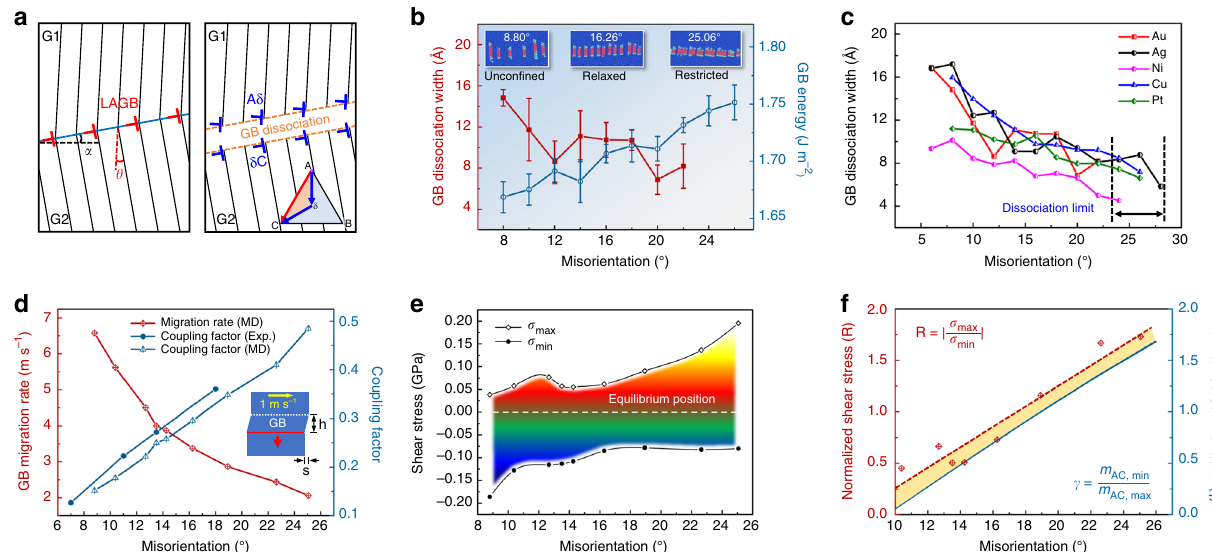
Fig. 3 Generality of the reversible deformation in a variety of metals with different dislocation-type GBs. a Geometrical model of the LAGB con fi guration before (left) and after (right) dissociation. The GB misorientation and inclination are indicated by θ and α in the schematic model, respectively. The inset illustrates the GB dissociation into two Shockley partials on the (111) slip plane. b GB dissociation width and corresponding GB energy for different misorientations. Error bars represent the standard deviations from statistical analyses, where n ranges from 6 to 13 for GB dissociation width (depending on the GB misorientation) and n = 3 for GB energy. c Variations in the GB dissociation width with increasing GB misorientation in different face-centred cubic (FCC) metallic bicrystals. The dashed lines mark the upper limits of the misorientation range for stable GB dissociation in different FCC nanocrystals. d Statistics of migration rates and shear coupling factors ( β = s / h , illustrated by the inset schematic) of LAGBs with different misorientations. e Ranges of applied shear stresses with respect to the GB misorientation. σ max and σ min denote the shear stresses that induced GB migration towards the bottom and top positions in each cycle, and the interval stress states are differentiated by the gradient colours. f Normalized applied shear stresses (R = | σ max / σ min | , red diamonds) derived from MD simulations, and normalized Schmid factors ( γ = m AC,min / m AC,max , blue curve) predicted from the geometrical model. The red dashed line is a linear fi tting of the normalized shear stresses.